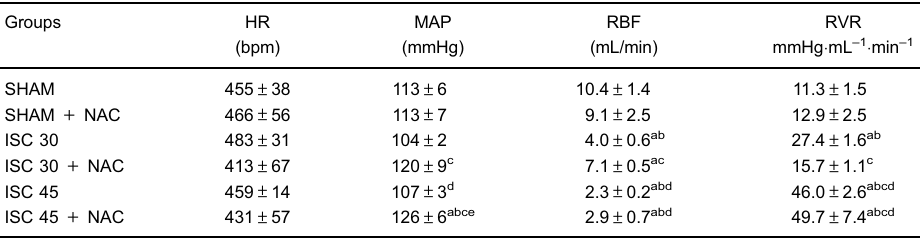
Table 2 . Effect of n-acetylcysteine (NAC) treatment on hemodynamic parameters after renal ischemia reperfusion injury. Groups